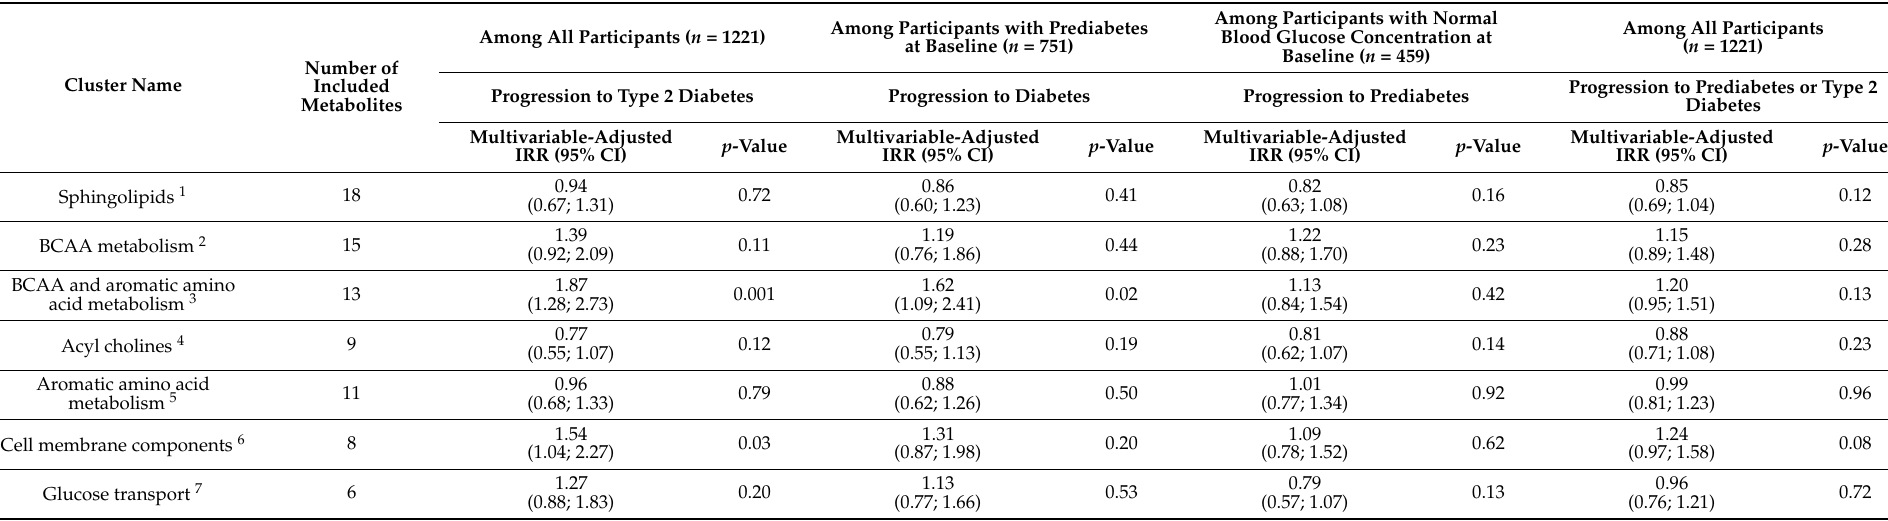
Table 2. Multivariable-adjusted pooled fixed-effects Incidence Rate Ratios (95% confidence intervals) for progression to type 2 diabetes and/or prediabetes, according to 1 standard deviation change in predefined clusters of metabolites in the San Juan Overweight Adult Longitudinal Study (SOALS) and Boston Puerto Rican Health Study (BPRHS)